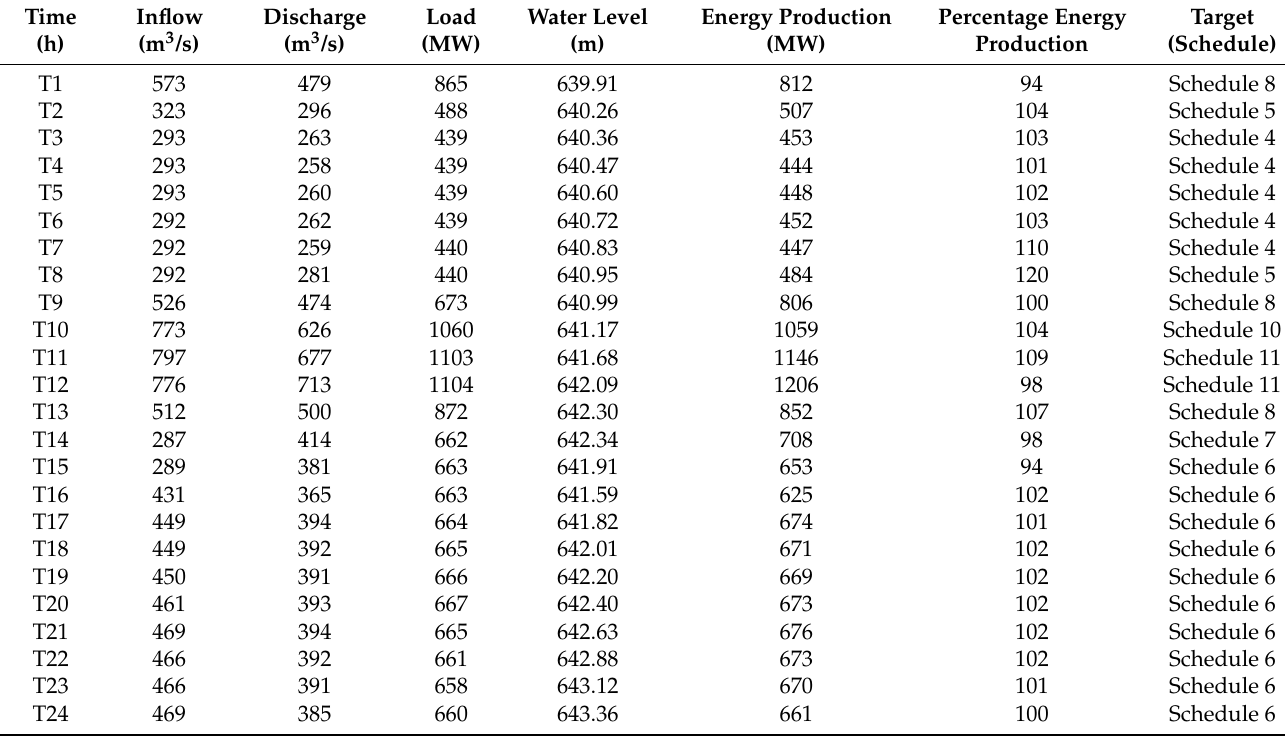
Table 4. Data set of Tianshengqiao plant 2 for the summer